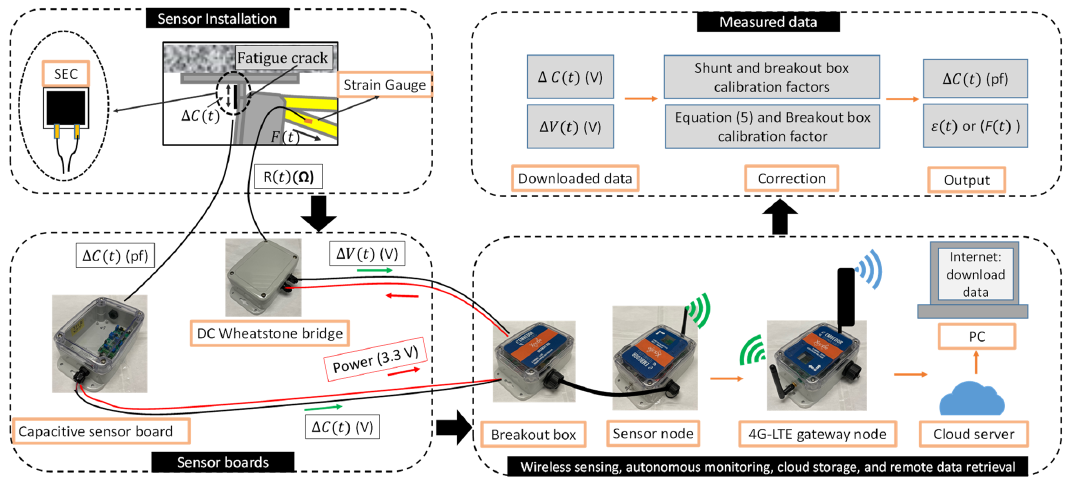
Figure 5 . The proposed WLASS for wireless sensing, cloud storage, and remote data retrieval for fatigue crack monitoring.